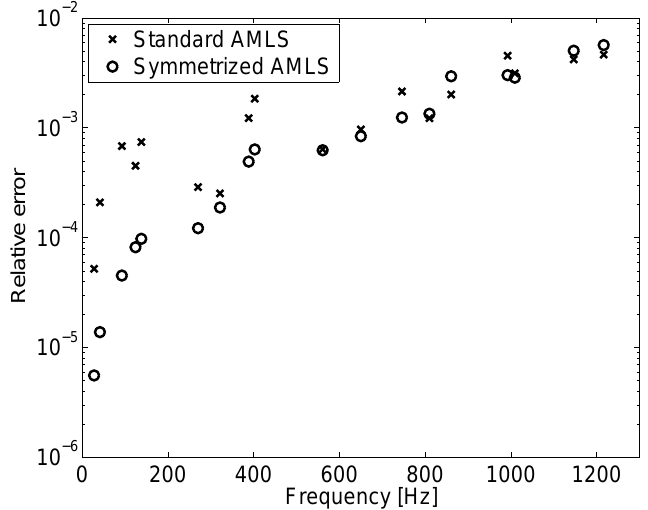
Figure 8. Relative error of adapted AMLS for fluid–solid interaction problems and relative error of standard AMLS applied to fluid–solid interaction